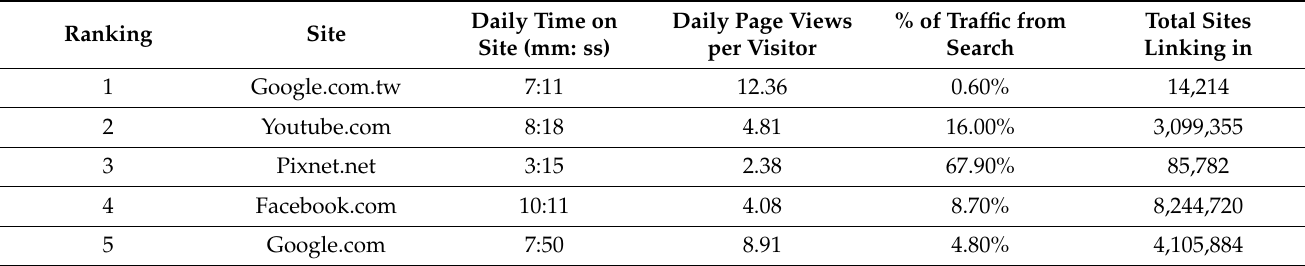
Table 1. The top ten sites with the highest media traffic in